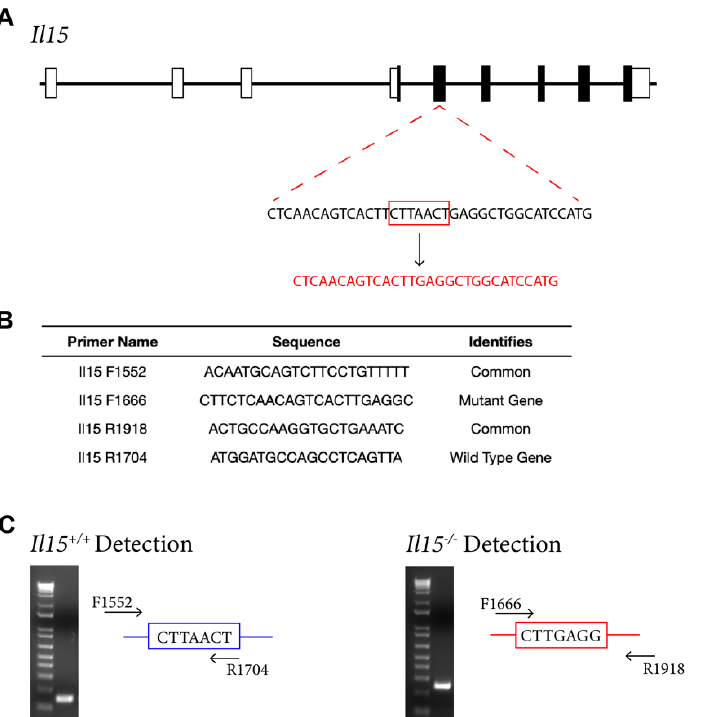
Figure 1 . Genetically modified Holtzmann Sprague-Dawley rats. Holtzmann Sprague-Dawley rats were genetically modified via zinc finger nucleases (ZFN) by Dr. Renaud to delete Il15 [26]. ( A ) The second coding exon of the rat Il15 gene was targeted via ZFN. Non-coding exon regions are represented with white boxes, coding exon regions with black boxes. The red box outlines the ZFN target sequence, which resulted in a 7-nucleotide deletion and subsequent frameshift (red text) for the Il15 − / − rats. ( B , C ) Four primers from Sigma-Aldrich were used to genotype the rats through PCR. The reverse primer (R1704) was specific to Il15 +/+ rats and produced a 152-bp band in combination with F1552. The forward primer (F1666) was specific to Il15 − / − rats and produced a 252bp-band in combination with R1918.